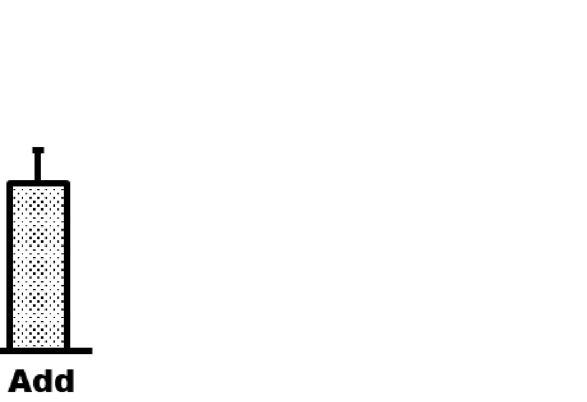
Figure 5. Average ± SD of conditioned MEP (% test pulse alone) from the FDI muscle during MI + AO of abduction (abd), adduction (add), and rest